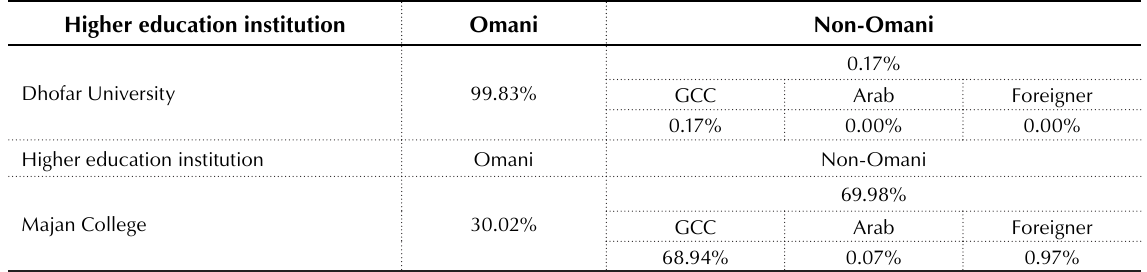
Table 3. Ownership structure